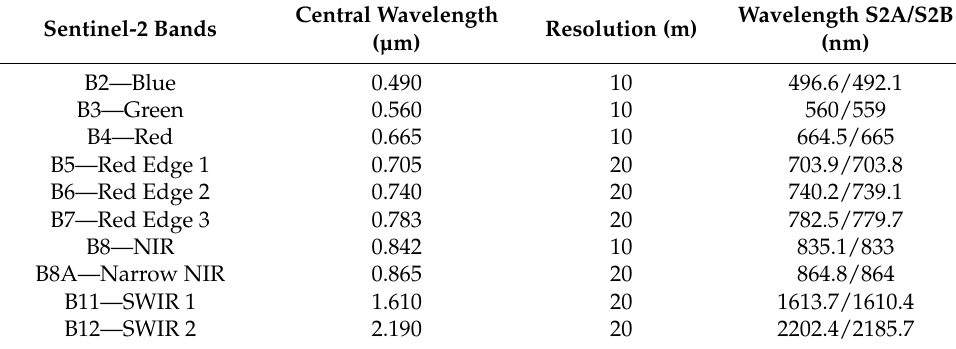
Table 1. Information about the Sentinel-2 bands selected in this study.